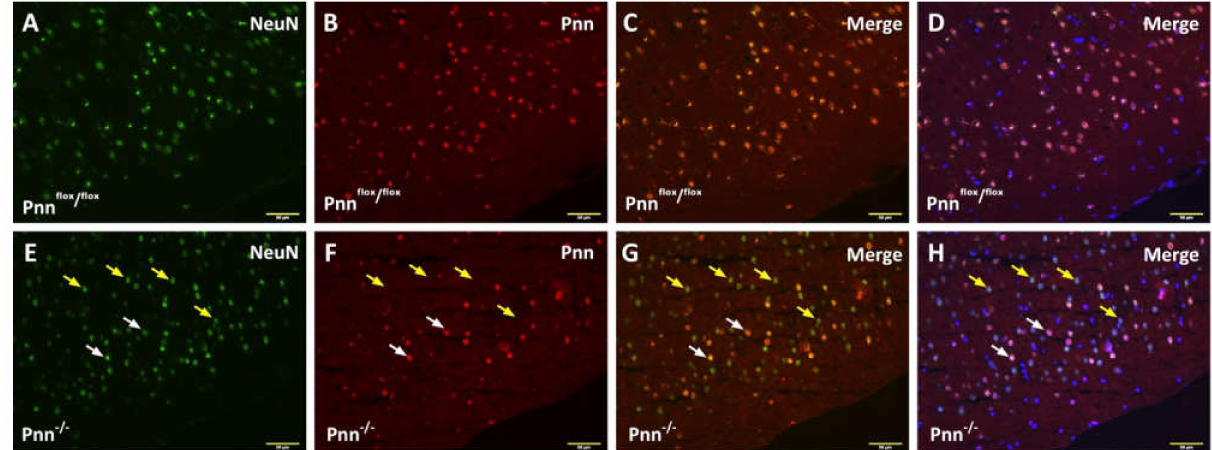
Figure 1. Immunofluorescent staining to examine neuronal Pnn depletion in cerebral cortex. ( A – D ) Immunofluorescent staining to detect cerebral Pnn expression in tamoxifen-injected Pnn flox/flox mice (without Cre-ERT2 transgene). ( E – H ) Immunofluorescent staining to detect cerebral Pnn expression in tamoxifen-injected CaMKII-CreERT2, Pnn flox/flox mice (Pnn -/- ). ( A , E ) NeuN+ neurons. ( B , F ) Pnn+ cells. ( C , G ) Merged images. ( D , H ) Merged images with DAPI-stained nuclei. In the cerebral cortex of Pnn flox/flox mice, the nuclear distribution of Pnn was found in all NeuN-positive neurons. In Pnn -/- mice, loss of Pnn expression in NeuN+ neurons was observed in cerebral cortex (yellow arrows in E – H ). However, due to the cell type-specific expression of CreERT2, Pnn was also observed in certain cerebral cortical NeuN+ neurons (white arrows in ( E – H )). Scale bar indicates 50 µ